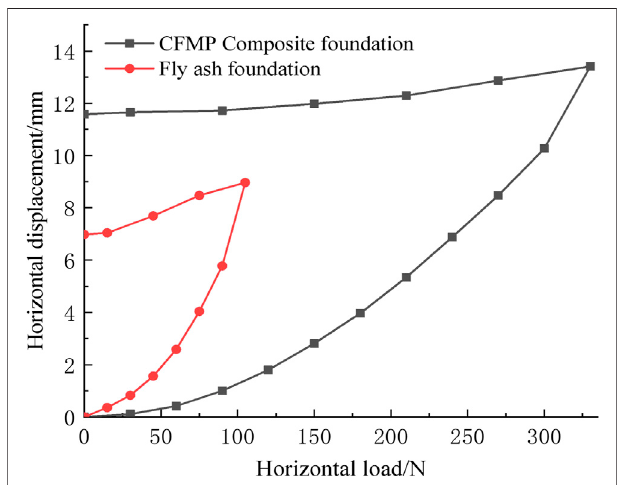
FIGURE 6 | Horizontal static load – displacement curve.